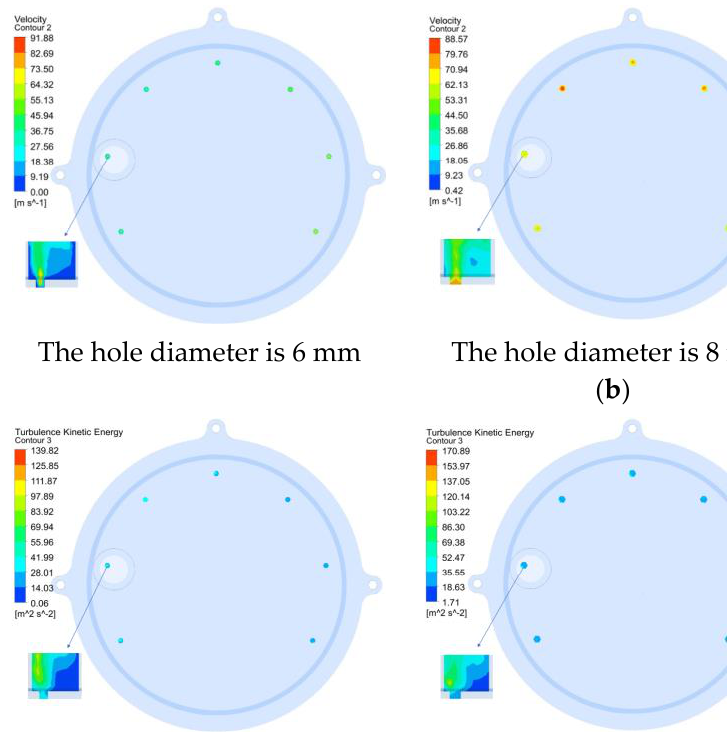
Figure 13. Influence of suction hole diameter on the negative pressure flow field. ( a ) Pressure program; ( b ) Velocity program; ( c ) The program of turbulent kinetic energy.